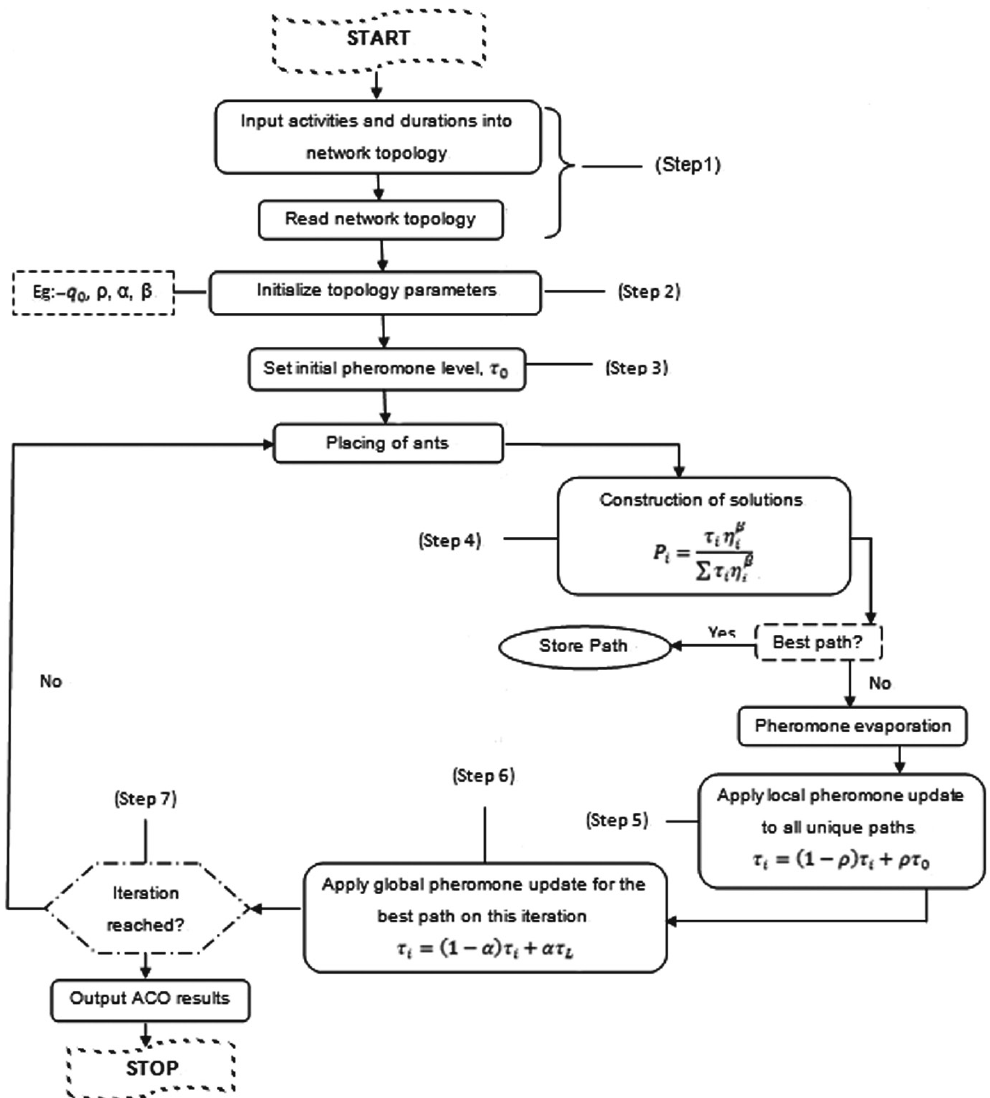
Fig. 1. ACO algorithm processes for the development of CSAM-ACO acceleration